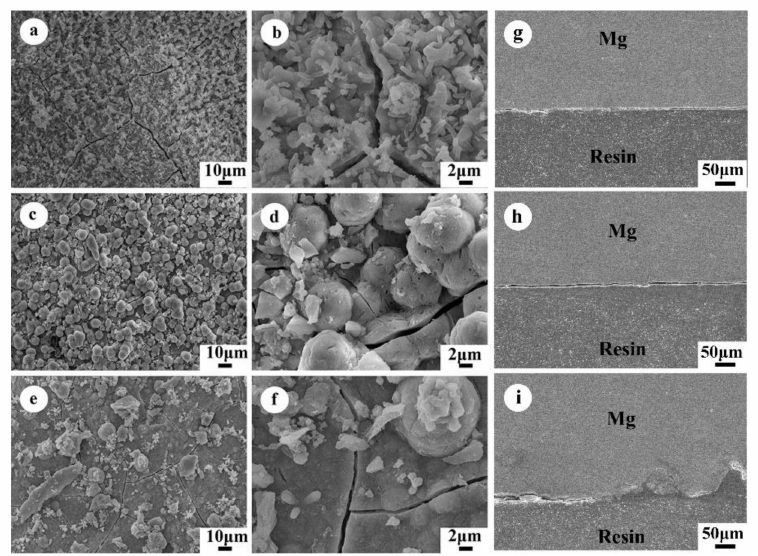
Figure 8. SEM images of HA5 ( a , b ), HA7 ( c , d ), and HA9 ( e , f ); and cross-section SEM images of HA5 ( g ), HA7 ( h ), and HA9 ( i ) after being soaked in Hank’s solution for seven